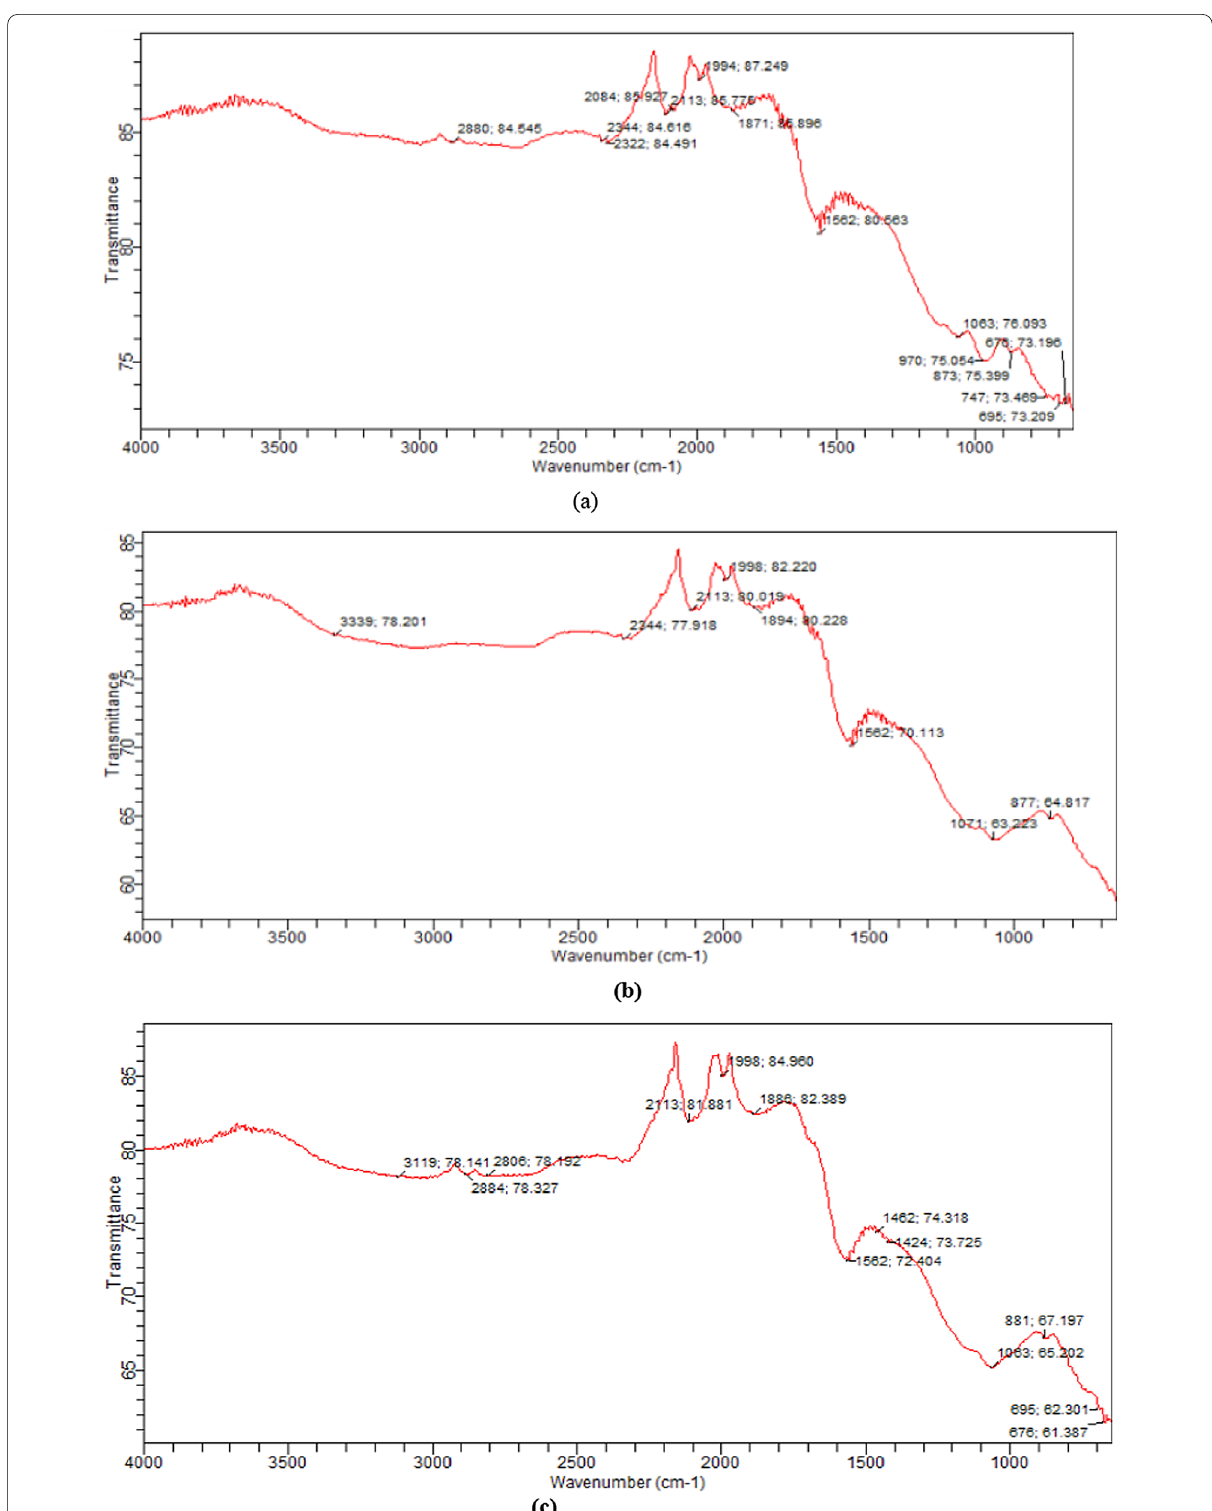
Fig. 1 FT-IR spectra of ACBGNS ( a ) before adsorption, ( b ) and ( c ) after the PE and PQ adsorption. The adsorbent (ACBGNS) was characterized using Cary 630, Agilent Technology model of Fourier Transform Infrared Spectrophotometer. The conducted FTIR experiment used a range of wave numbers (650–4000 cm − 1 ) with 32 scans at 8 cm − 1